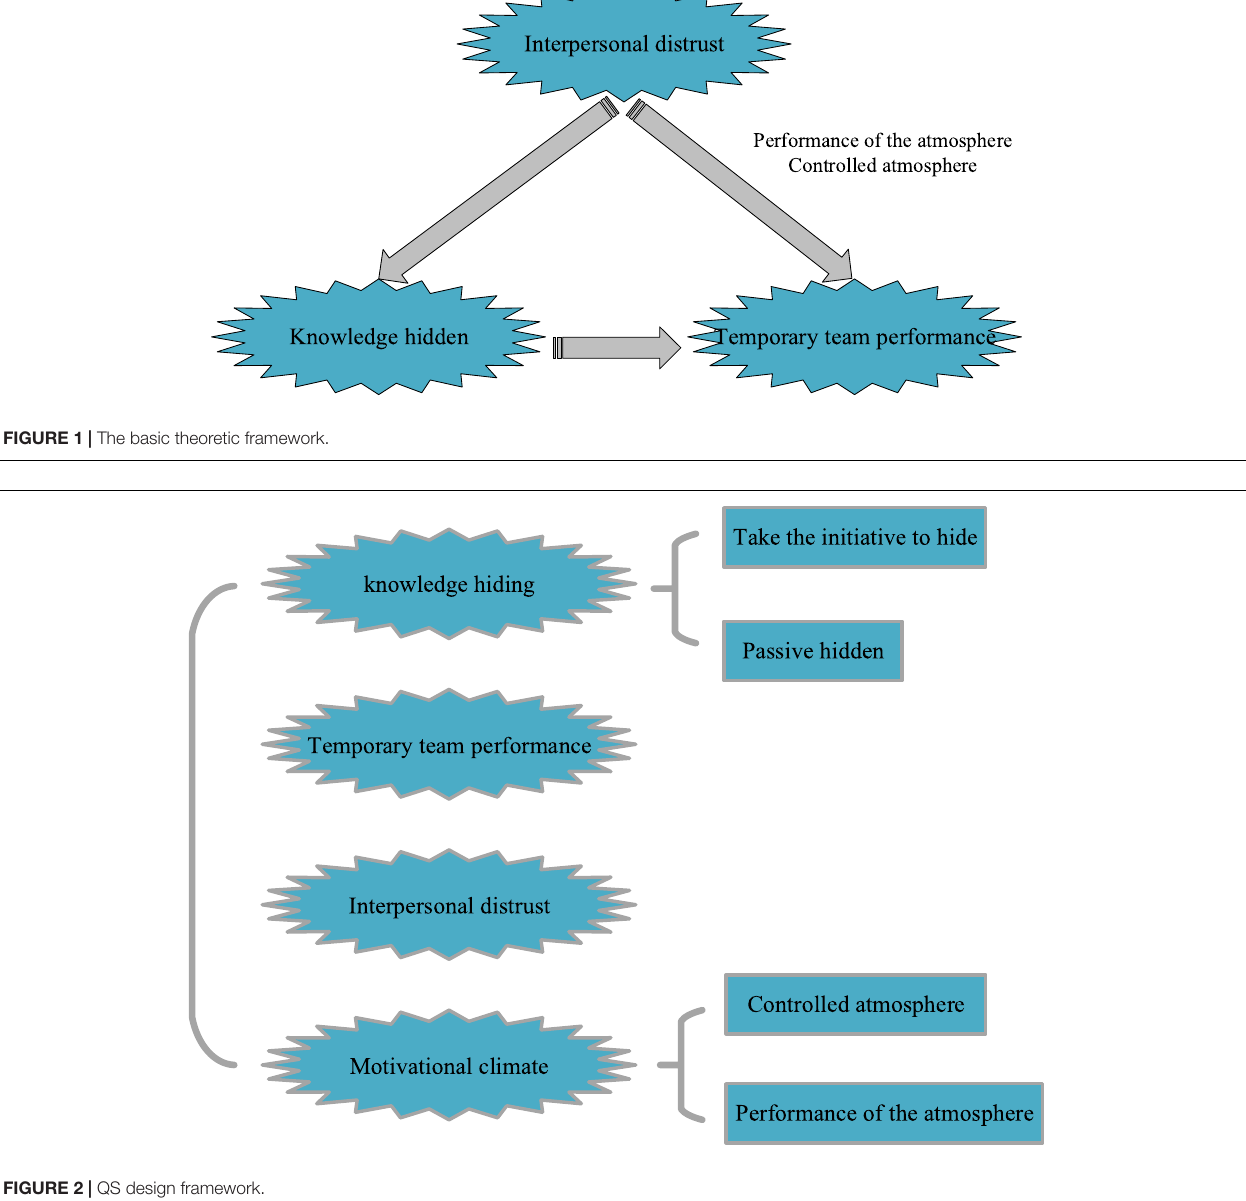
FIGURE 2 | QS design